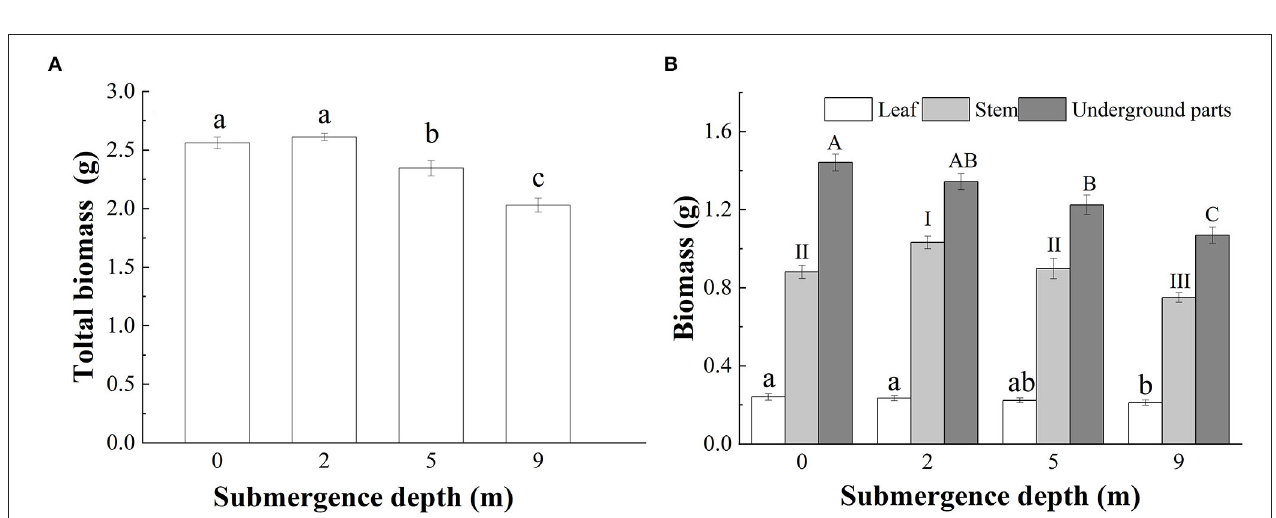
FIGURE 5 | Biomass of (A) whole plant; and (B) leaves, stems, and underground parts of A. philoxeroides at the end of submergence treatments (Mean ± S.E, n = 20). Different lower-case letters indicate significant differences ( p < 0.05) in the total plant mass (A) and the leaf mass (B) between treatments, different roman letters, and upper-case letters, respectively indicate significant differences ( p < 0.05) in stem mass and underground plant mass between treatments.